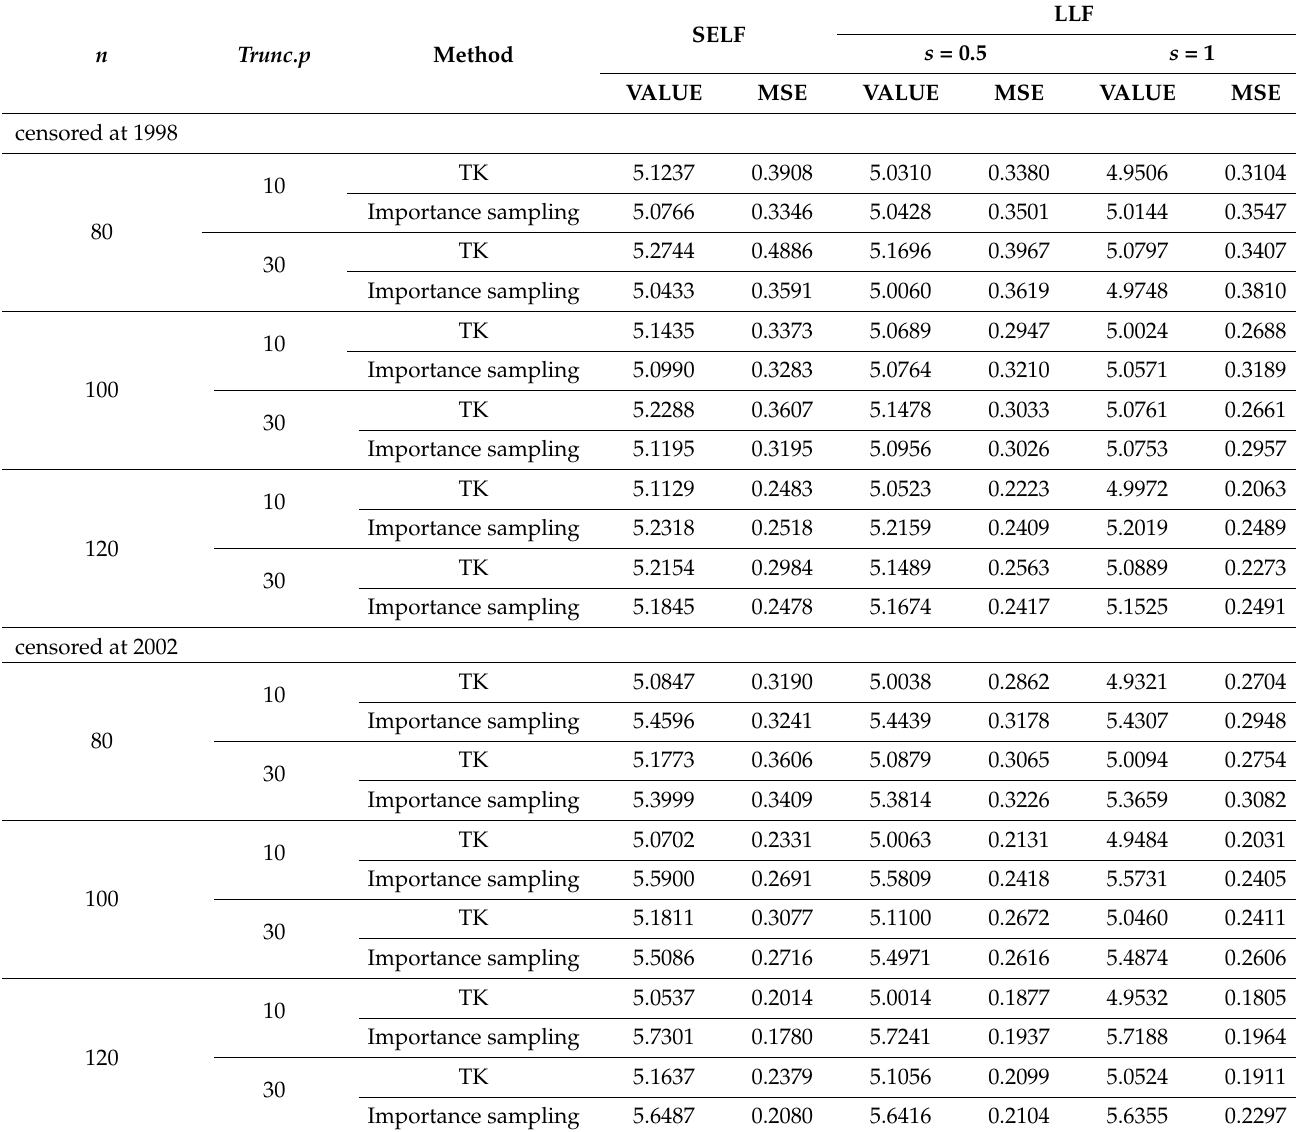
Table A1. The results of non-informative Bayesian estimates for σ using TK approximation and importance